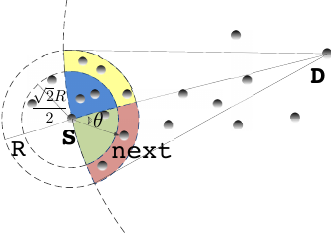
Figure 3. Speed up-greedy perimeter stateless routing (SU-GPSR) region partition